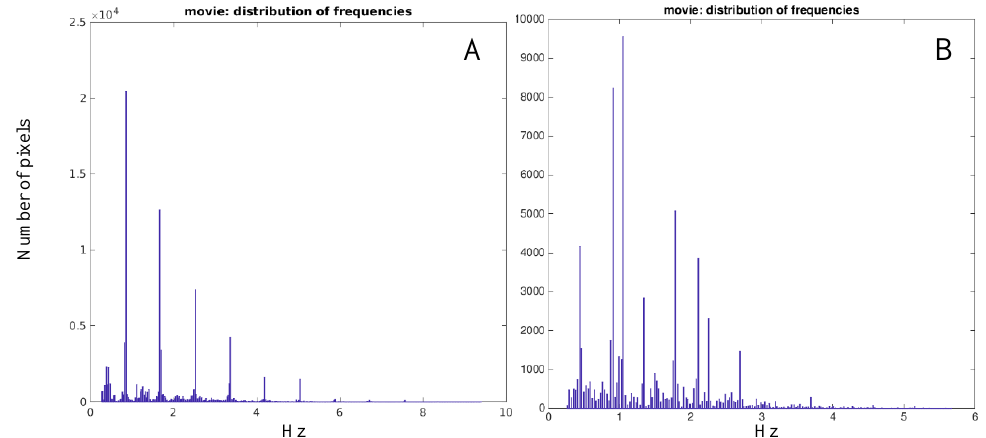
Figure 1. Panel ( A ) shows the histogram of a person walking with a well-coordinated motion pattern. Panel ( B ) shows the histogram of a man affected by Parkinson’s disease walking.